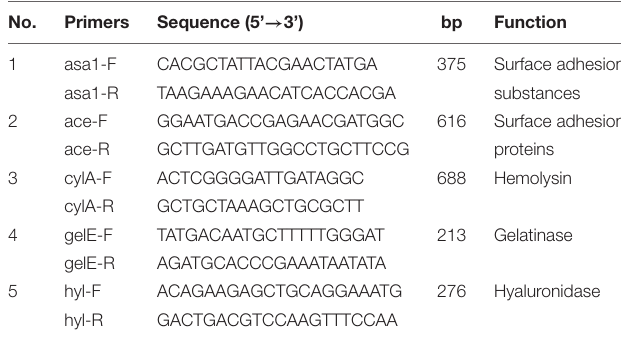
TABLE 1 | PCR primers for virulence gene